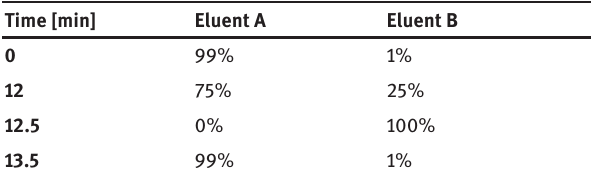
MS parameters were as follows: capillary voltage − 2.0 kV; a sampling cone voltage − 45 V; the gas flow on the cone − 11 L h -1 , the collision energy of 50 eV. The camera was set to positive and negative ion scanning modes, m/z 100 to 2500. The system worked with software Mass- Lynx TM V 4.1.